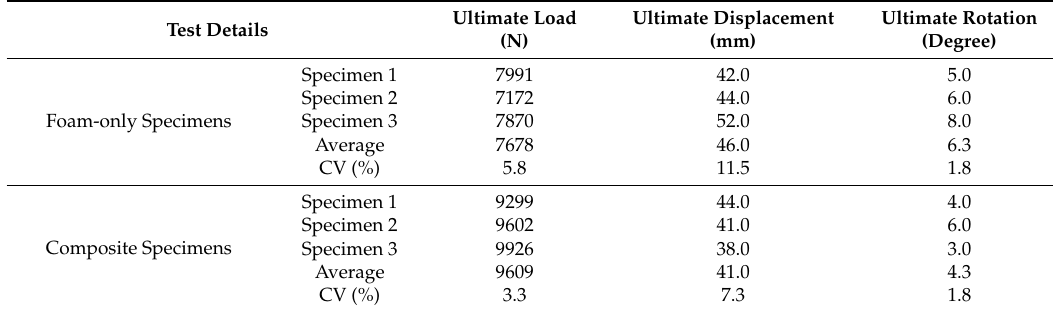
Table 3. Summary of the experimental carried tests for both simple and composite systems.